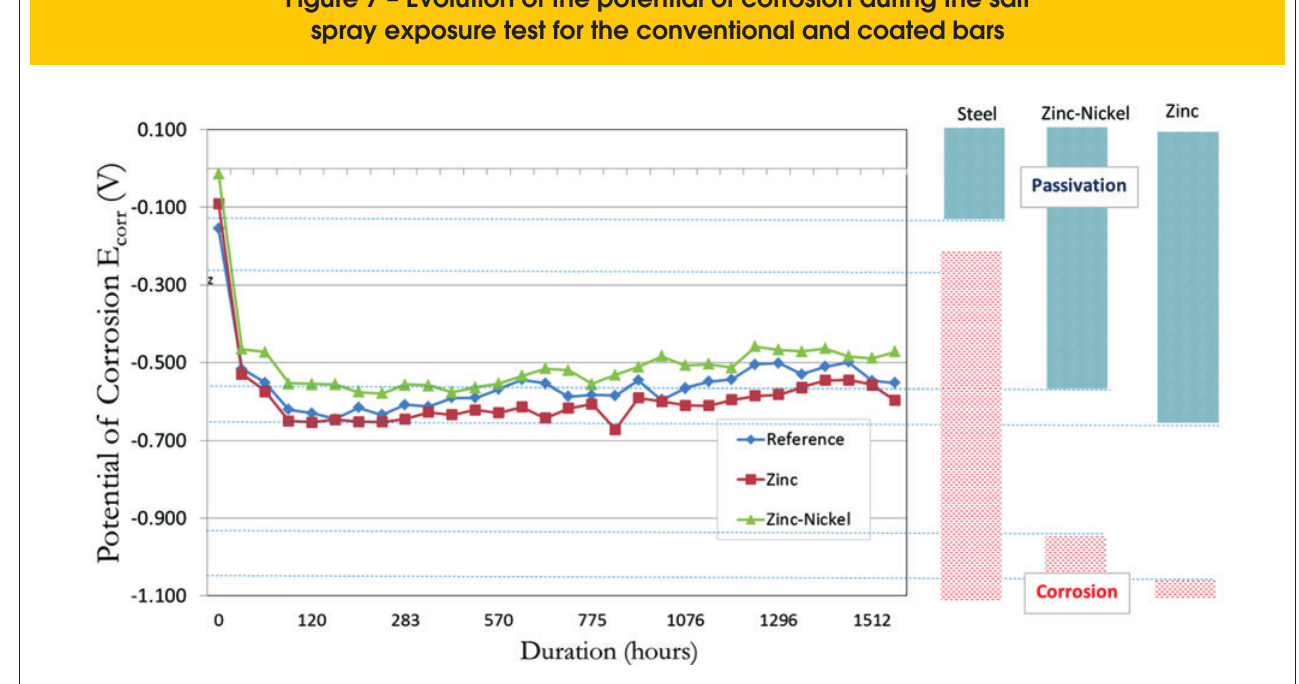
Figure 7 – Evolution of the potential of corrosion during the salt spray exposure test for the conventional and coated